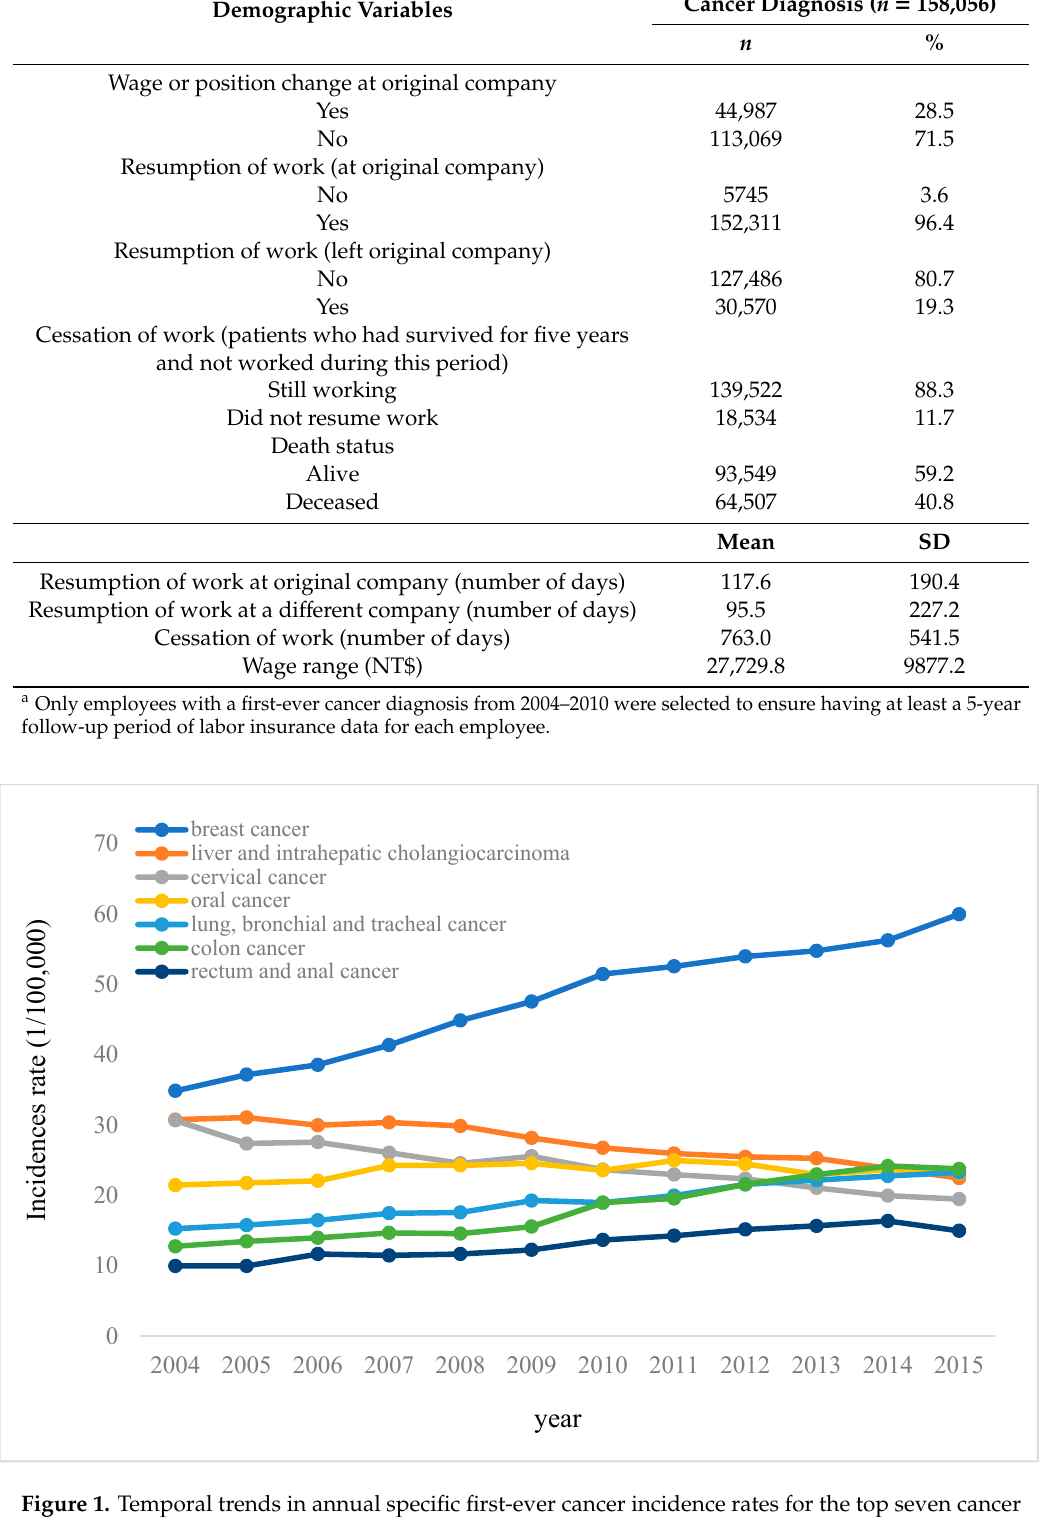
Figure 1. Temporal trends in annual specific first-ever cancer incidence rates for the top seven cancer types among insured workers in Taiwan, 2004–2015.